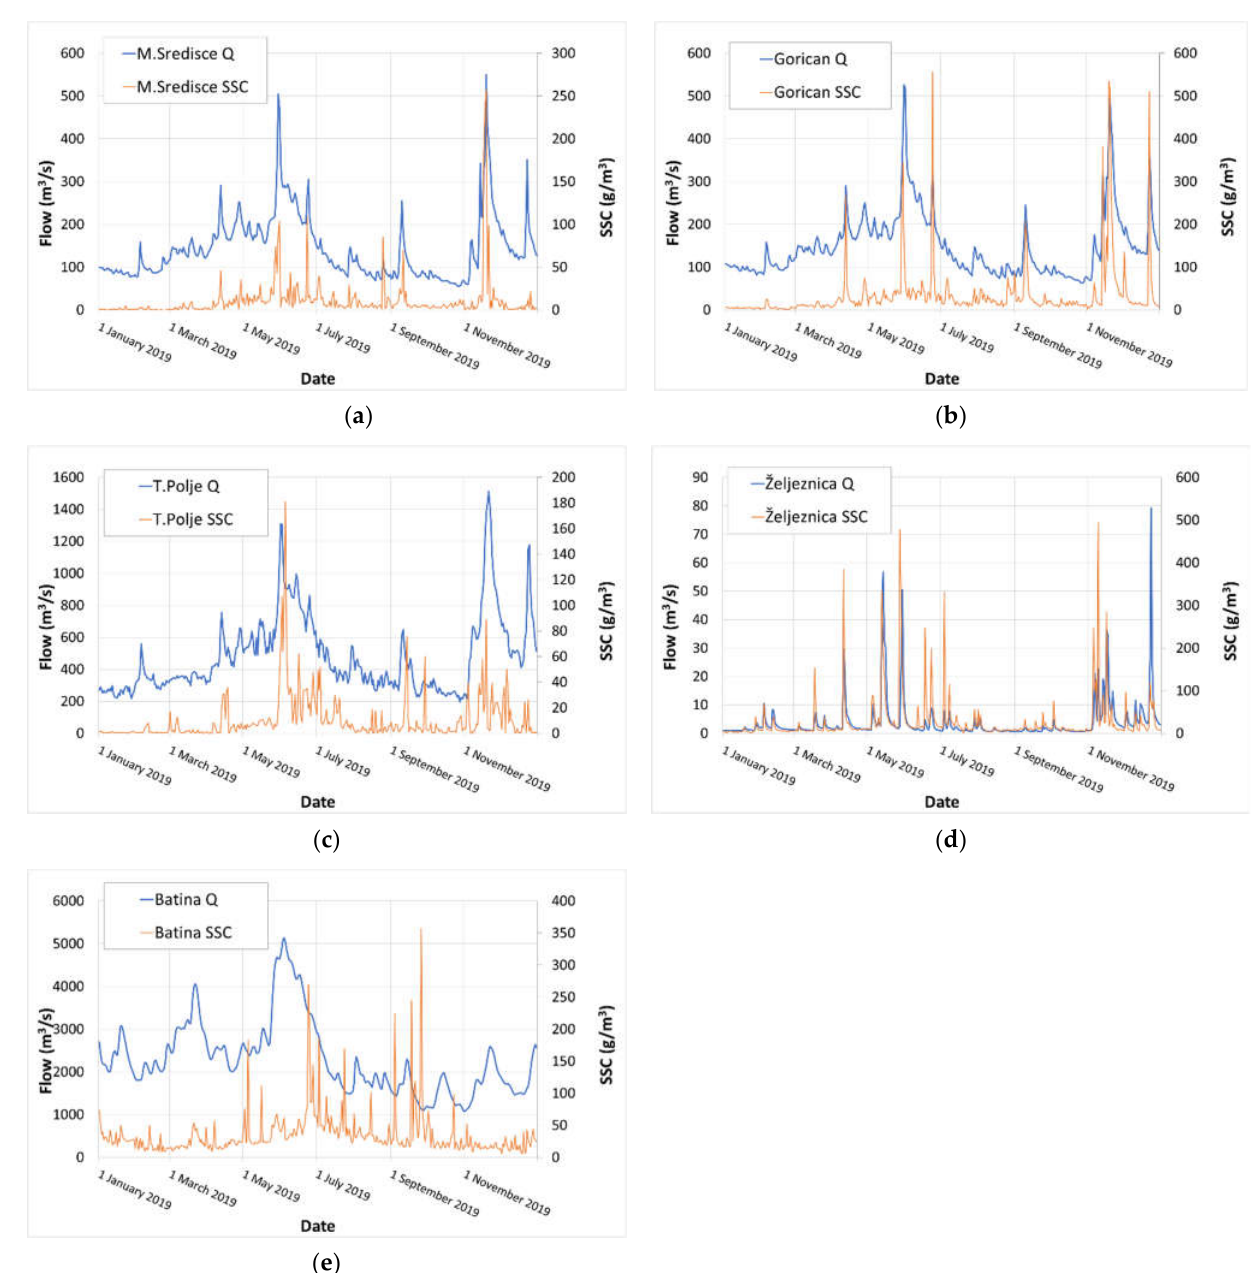
Figure 2. Daily flow and SSC distribution in 2019: ( a ) HS Mura-Mursko Sredisce; ( b ) HS Mura- Goričan; ( c ) HS Drava-Terezino Polje; ( d ) HS Bednja-Željeznica; ( e ) HS Dunav-Batina.